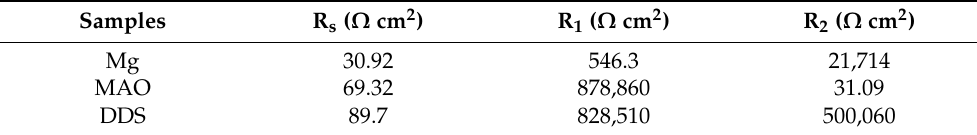
Table 3. Values of equivalent elements in impedance models of different